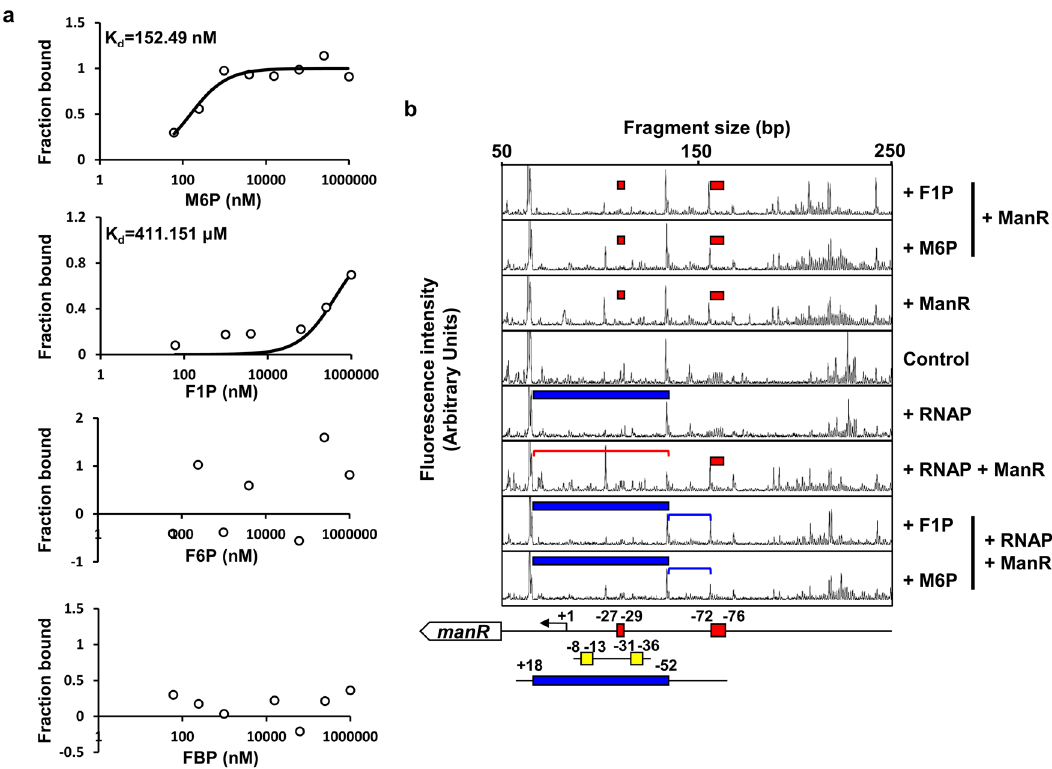
Fig. 5 ManR binds to M6P and F1P to facilitate RNAP binding to the promoter. a Binding af fi nities of ManR with mannose 6-phosphate (M6P), fructose 1-phosphate (F1P), fructose 6-phosphate (F6P), and fructose 1-phosphate (F1P), measured using NanoTemper Monolith NT.115 pico . The dissociation constants (K d ) of ManR with M6P and F1P were obtained as approximately 152.49 nM and 411.15 μ M, respectively. b Effect of M6P or F1P on ManR-mediated transcriptional activation of manR was assessed by DNase I footprinting assay. A 6-FAM-labeled manR probe (200 ng) was incubated with either hybrid RNAP holoenzyme (0.7 μ g of E. coli core RNAP and 1.4 μ g V. cholerae σ 70 ) or ManR (700 ng) in a different combination in the absence or presence of 2 mM M6P or F1P as indicated. The DNA regions encompassing − 52 to + 18 and − 71 to − 53 relative to the manR TSS are indicated with red and blue lines, respectively. The DNA regions protected from DNase I digestion by ManR (red bars) and RNAP (blue bars) were then determined. Schematic diagrams of the manR promoter region is shown below, and ManR-binding sites, − 35 and − 10 elements, and RNAP-binding sites are depicted in red, yellow, and blue rectangles, respectively. Nucleotide positions are numbered relative to the manR TSS and the bent arrow indicates the manR TSS. The fl uorescence intensity of the 6- FAM-labeled fragments is shown on the y -axis of each electropherogram and fragment sizes were determined by comparison with the internal molecular weight